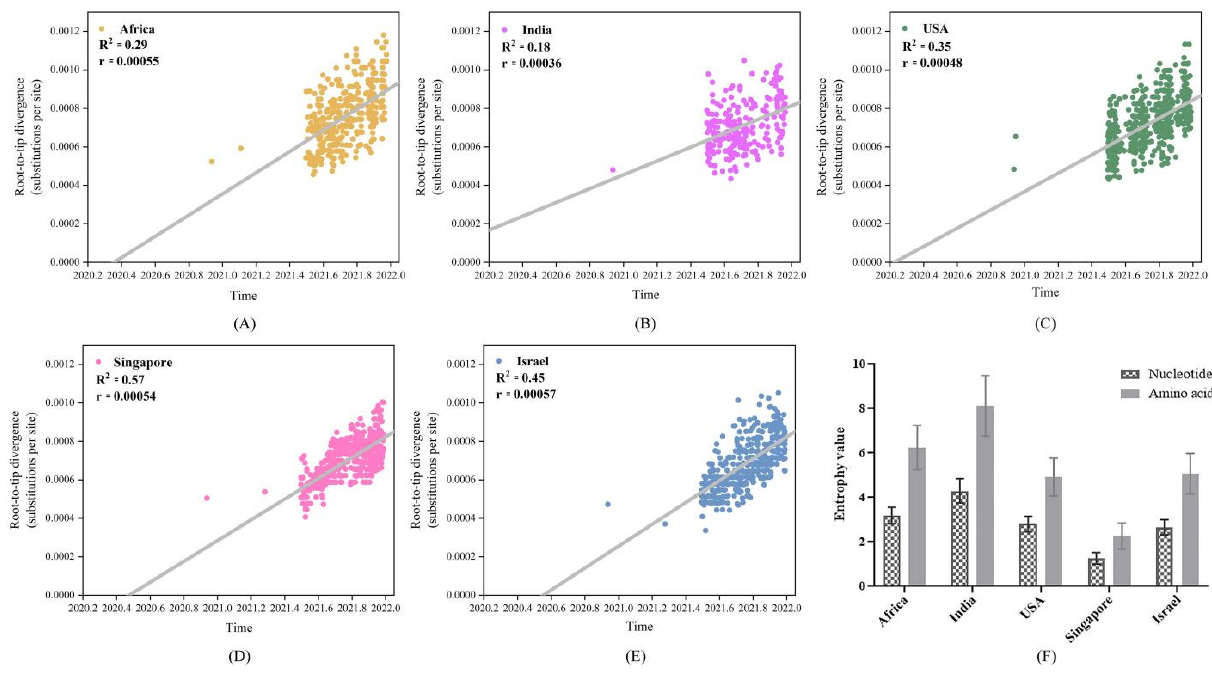
Figure 2. Genetic divergence plot of the SARS-CoV-2 sequences in different countries/regions. ( A – E ) Root-to-tip regression analysis. The phylogeny of Singaporean sequences exhibited the strongest association, followed by Israel and the USA, while the African and Indian sequences showed more diffuse regression plots. ( F ). Genetic variability of the Spike (S) sequences. The S sequences from India and Singapore, respectively, presented the highest and the lowest diversity at both the nucleotide and amino acid levels. Bars stand for the mean value calculated from individual residues values. Standard errors are shown for each bar.